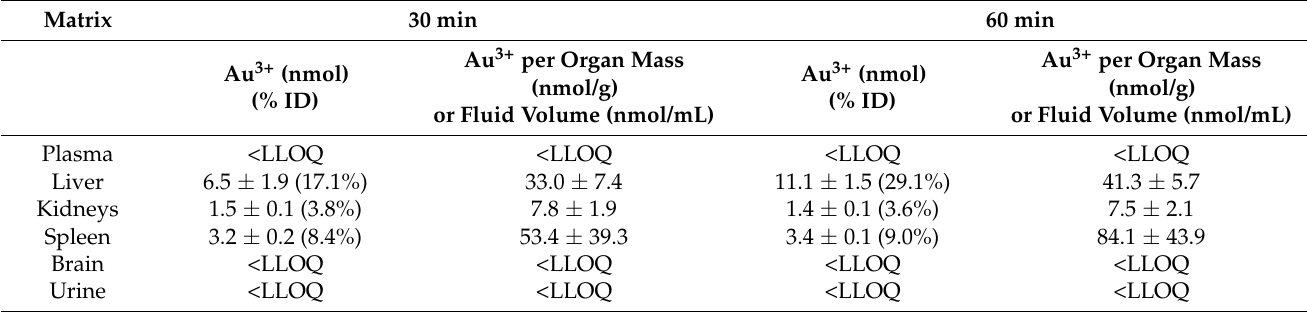
Table 6. Gold quantification and concentration in mice tissues and fluid after 30 min and 1